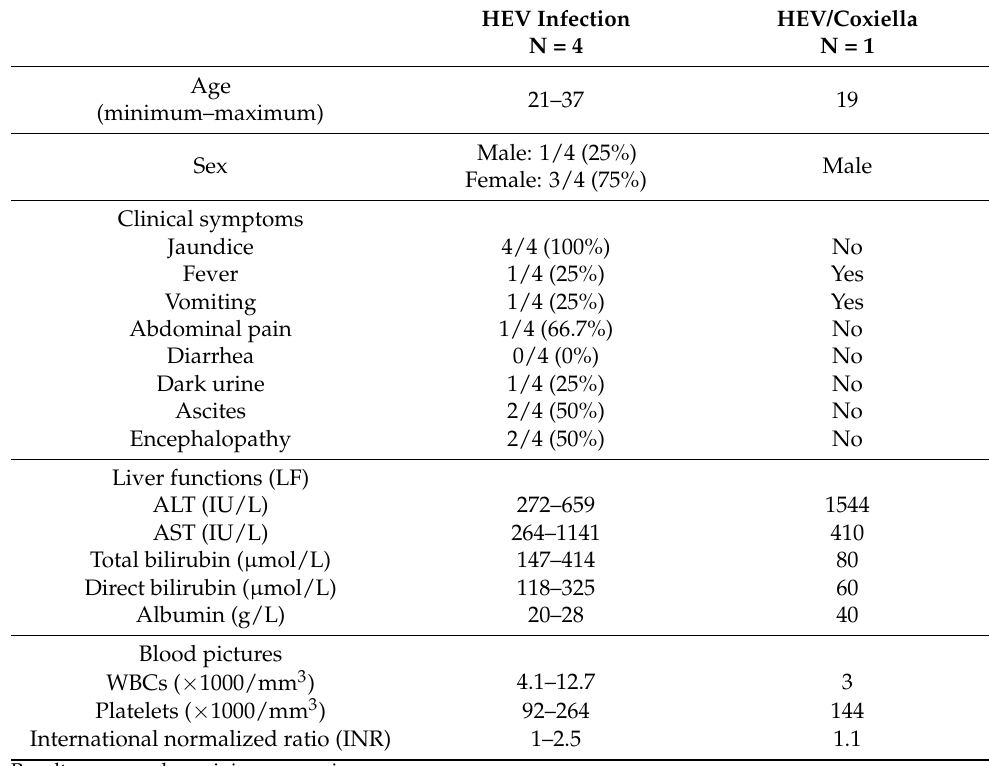
Table 5. Characteristics of acute hepatitis caused by HEV and coinfection